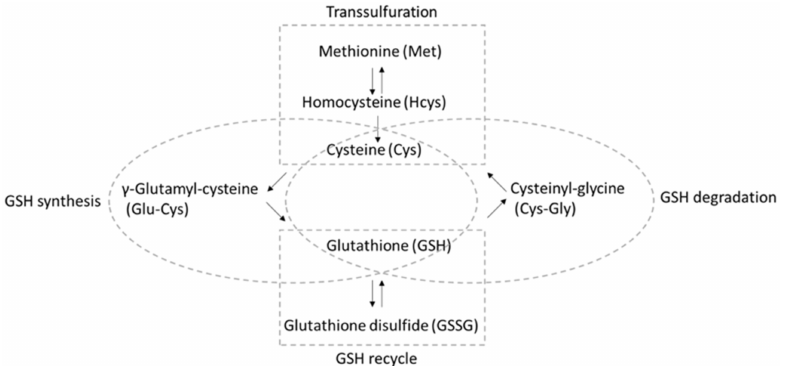
Figure 1. Analytes included in the “thiol profile” HPLC-MS/MS method described here and the pathways in which they